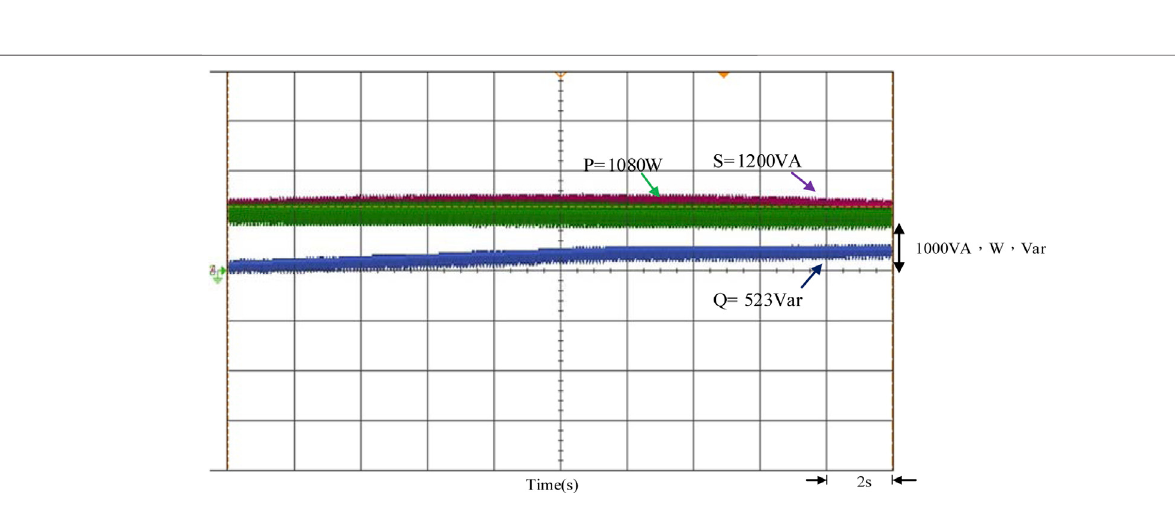
Frontiers in Energy Research |